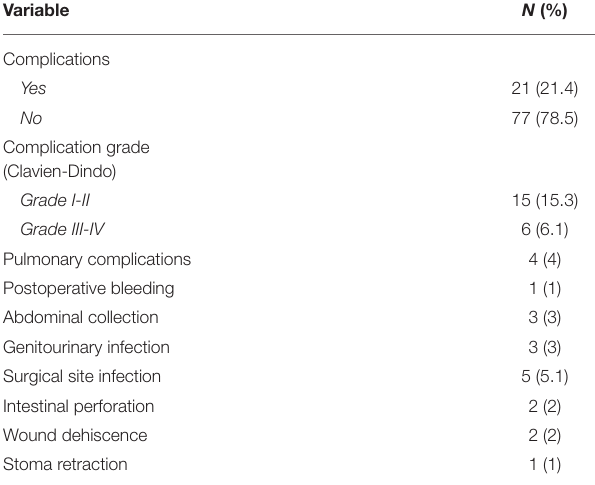
TABLE 3 | Postoperative complications.